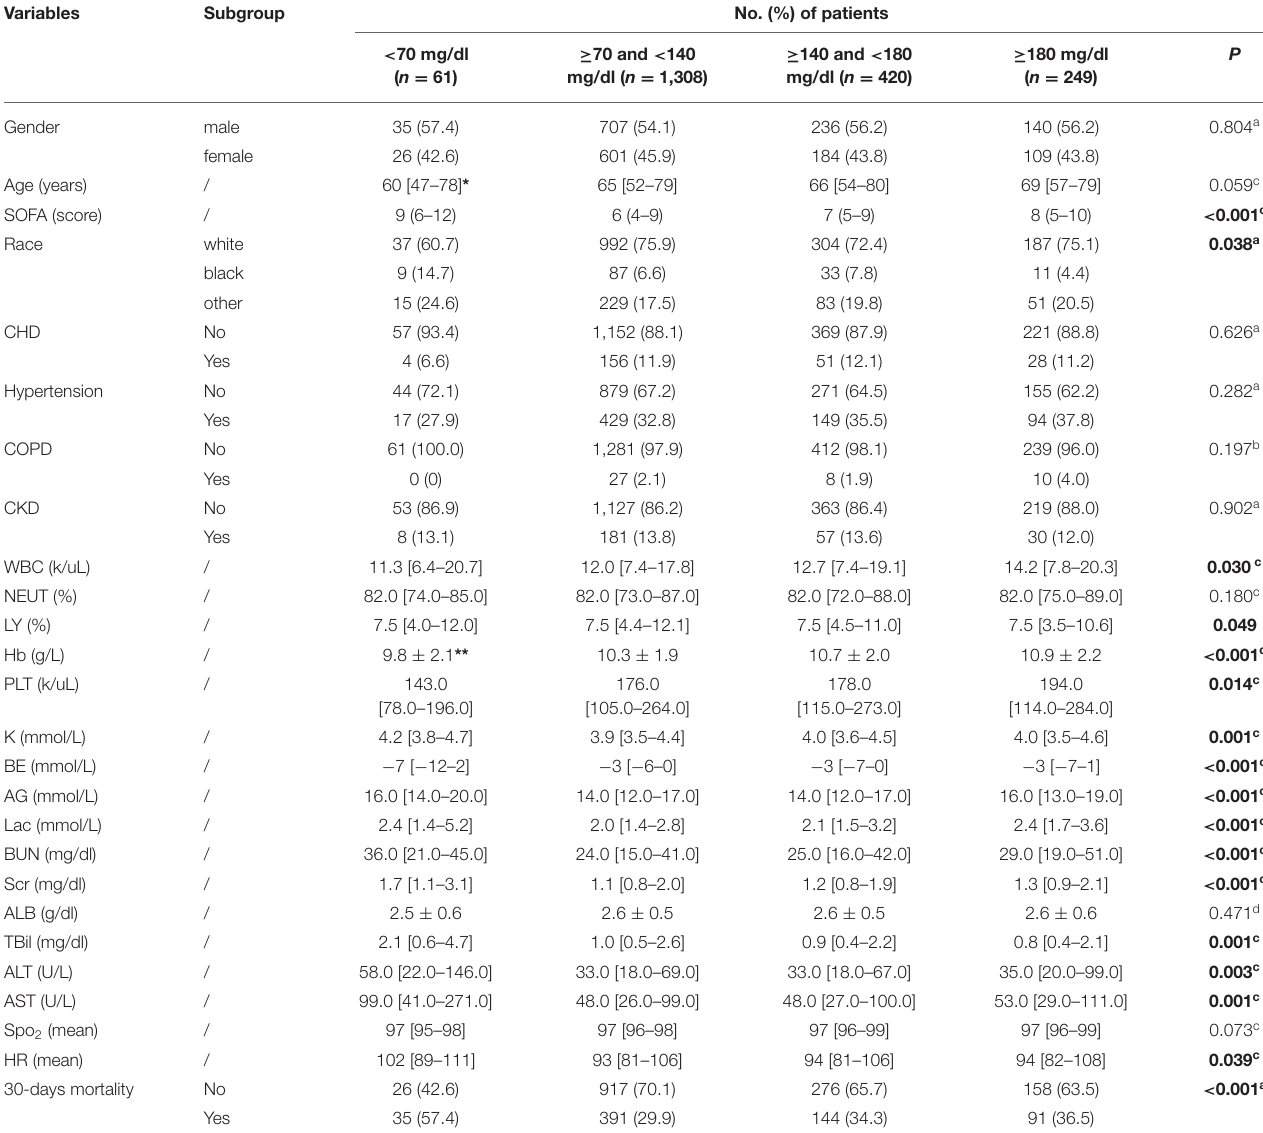
TABLE 2 | The demographic characteristics of septic patients without diabetes in different blood glucose levels.